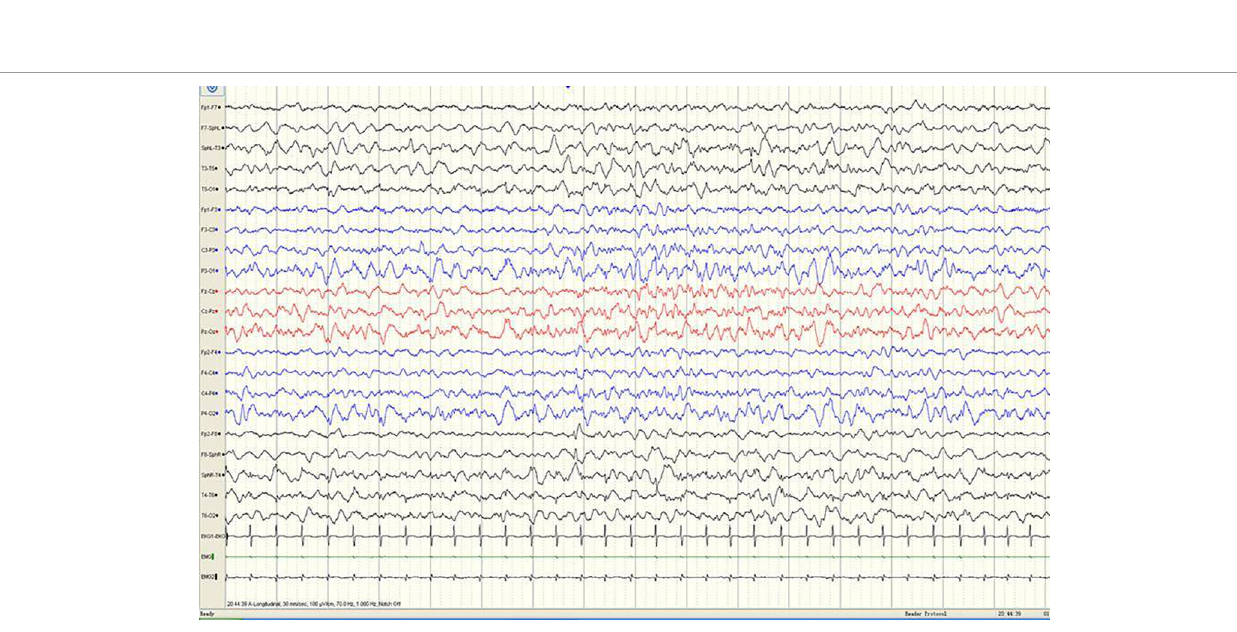
FIGURE 1 | A sample EEG recording of 4-month-old child in this study. The interictal EEG recording shows a sharp slow wave discharge in the left anterior temporal